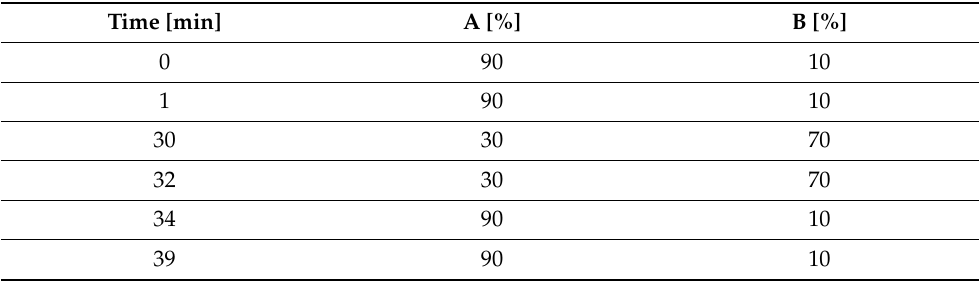
Table 4. LC-MS method